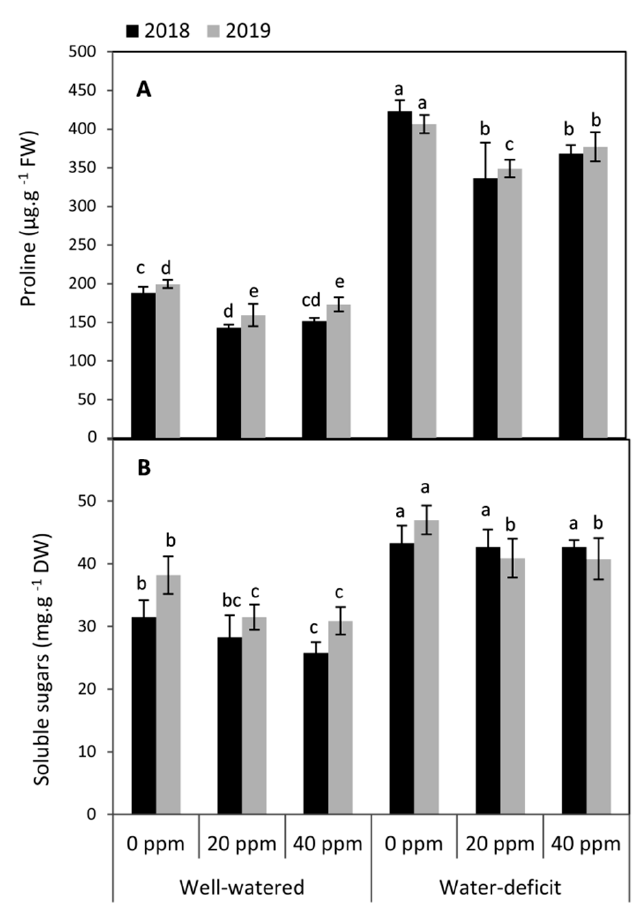
Figure 2. Effect of foliar application of melatonin (MT) at 0, 20 and 40 ppm on proline ( A ) and soluble sugars ( B ) of tomato plants grown under well-watered and water deficit conditions in the seasons of 2018 and 2019. Means of three replicates were presented ± SD. Different letters are significant differences, according to Duncan’s multiple range tests ( p < 0.05).